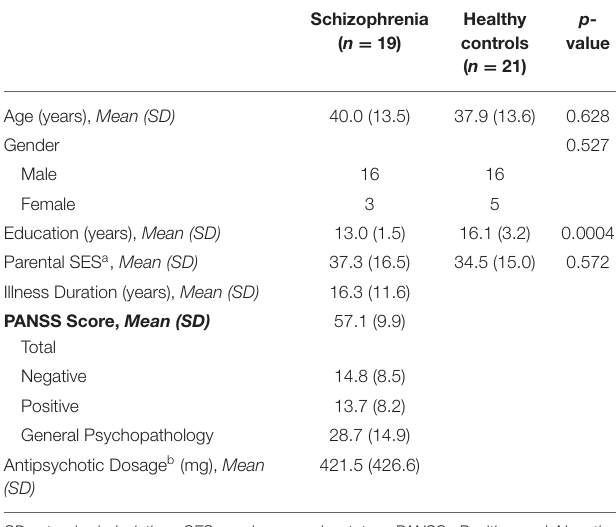
TABLE 1 | Participant demographics and clinical